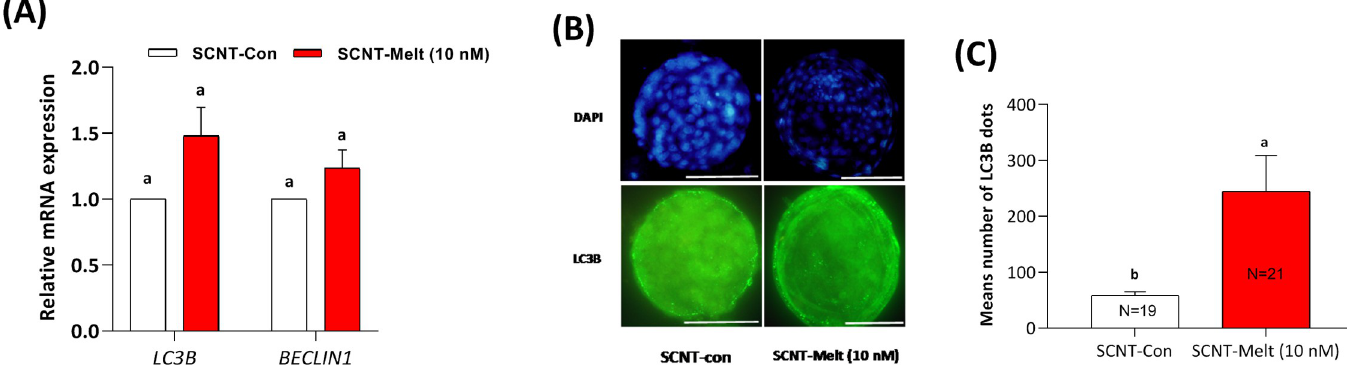
Fig 5. Effect of melatonin on the autophagy status of derived blastocysts. A) The relative expression levels of autophagy genes ( LC3B and BECLINE1 ) in SCNT-Melt (10 nM) and SCNT-Con groups. B) Representative images of LC3B protein dots in ovine SCNT embryos. Scale bar, 100 μ m C) The mean number of LC3B dot in ovine SCNT embryos treated with 10 nM melatonin compared to control group. The data were shown as mean ± SEM. Values with different letters have a statistically significant difference (P < 0.05).